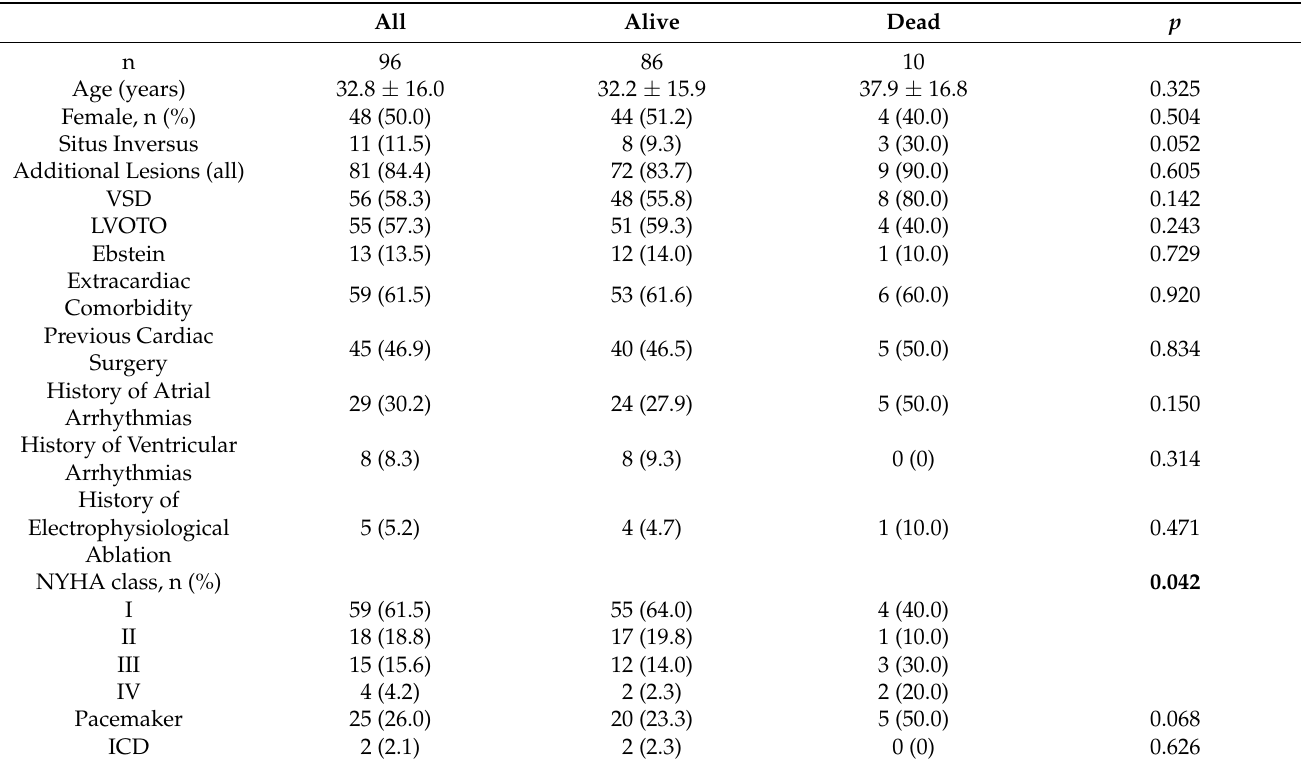
Table 1. Baseline characteristics.